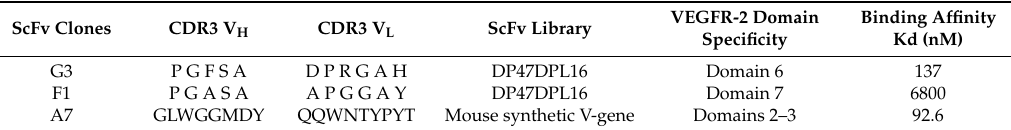
Table 1. Summary table showing CDR3 sequences of heavy and light chains, ETH-2 Gold library, domain specificities, and binding affinities of selected